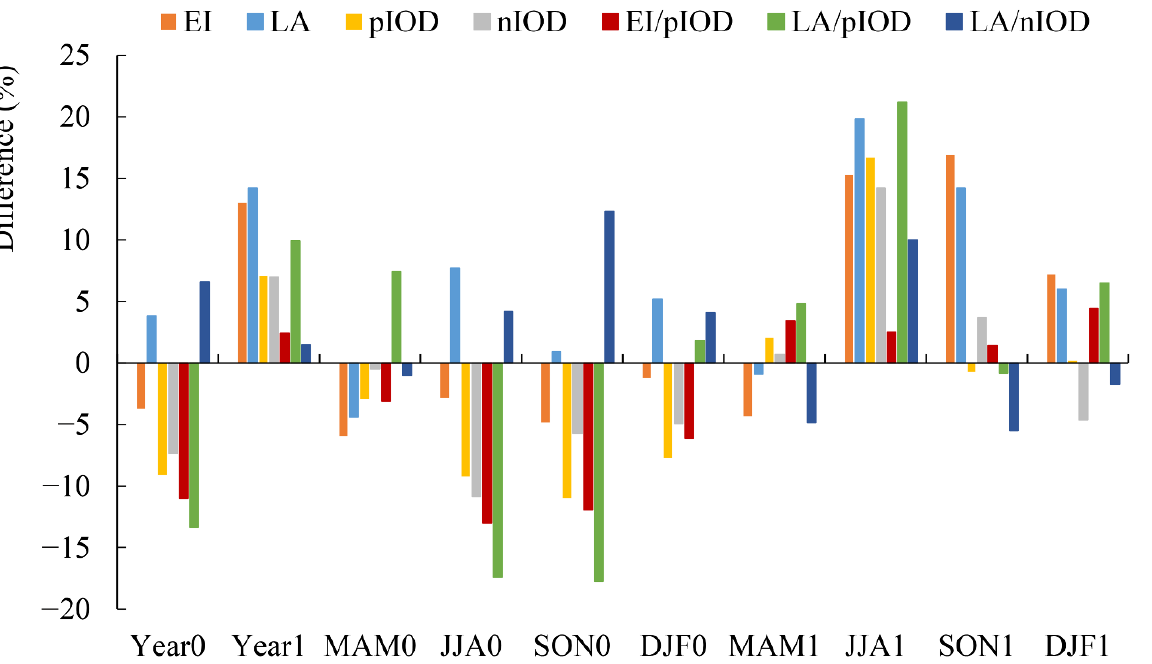
Figure 5. The relative difference of annual and seasonal streamflow in different groups of ENSO and IOD events in the Jinsha River Basin (1961–2016). (0, developing year; 1, decaying year; MAM, March-April-May; JJA, June-July-August; SON, September-October-November; DJF, December-January-February. Note: Difference = (streamflow in ENSO/IOD years − streamflow in neutral years)/streamflow in neutral years * 100).